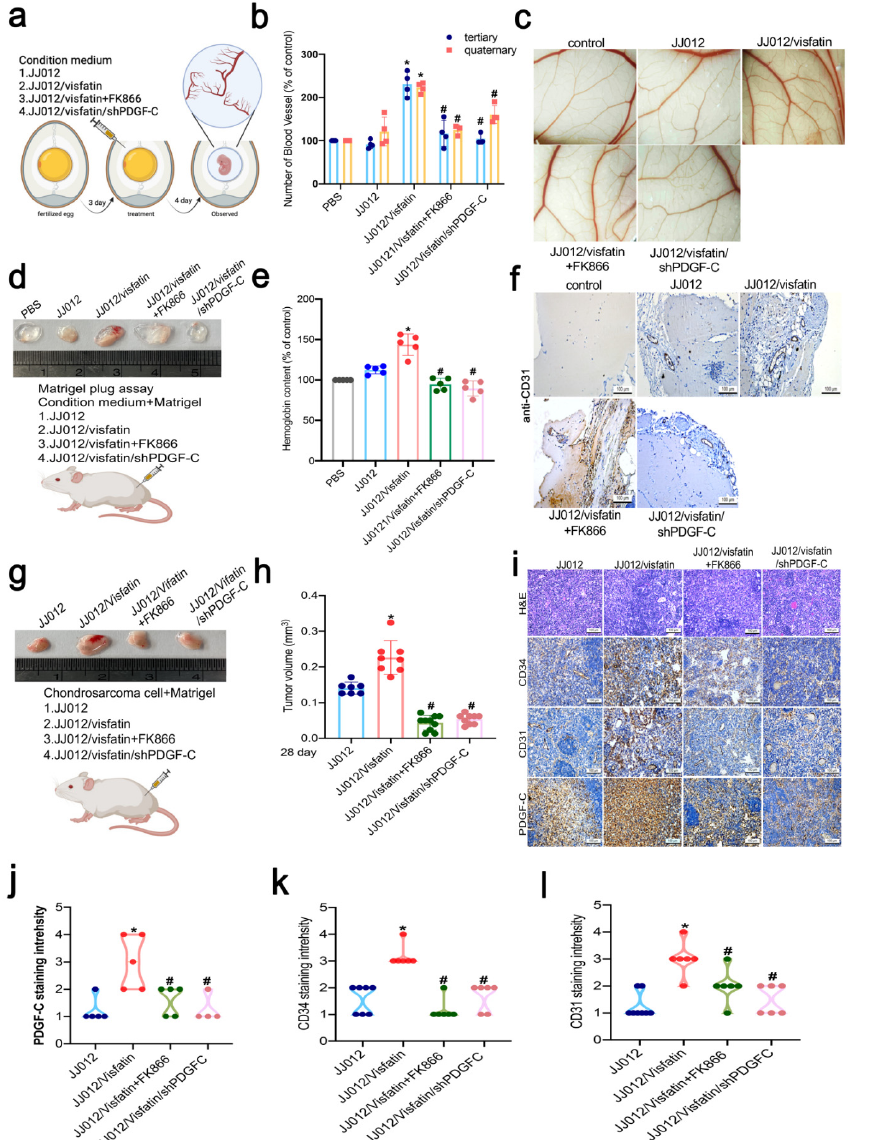
Figure 6. Knockdown of PDGF-C expression and FK866 treatment of human chondrosarcoma cells reduced tumor-promoted angiogenesis in vivo. ( a – c ) Fourteen-day-old chicken embryos were incu- bated with CM under specified conditions for 4 days before being excised and fixed in chorioallantoic membrane (CAM), then photographed with a stereomicroscope; ( d – f ) mice were injected subcuta- neously with Matrigel mixed with indicated chondrosarcoma CMs for 7 days. Plugs were excised from the mice and photographed. Hemoglobin content was quantified and embedded in paraffin and the sections were immunostained with CD31 antibody; ( g – i ) chondrosarcoma cell lines were mixed with Matrigel, then injected into the mices’ flanks and observed for 4 weeks, before sacrificing the mice and removing the tumors. Photographs were taken of the tumors with a microscope and quantified for volume; ( j – l ) IHC analyses were performed of CD31, CD34, and PDGF-C expression in chondrosarcoma xenograft tissue. Quantitative results are expressed as means ± SD. Compared with the JJ012 group, * p -values < 0.05; compared with the JJ012/visfatin group, # p -values <